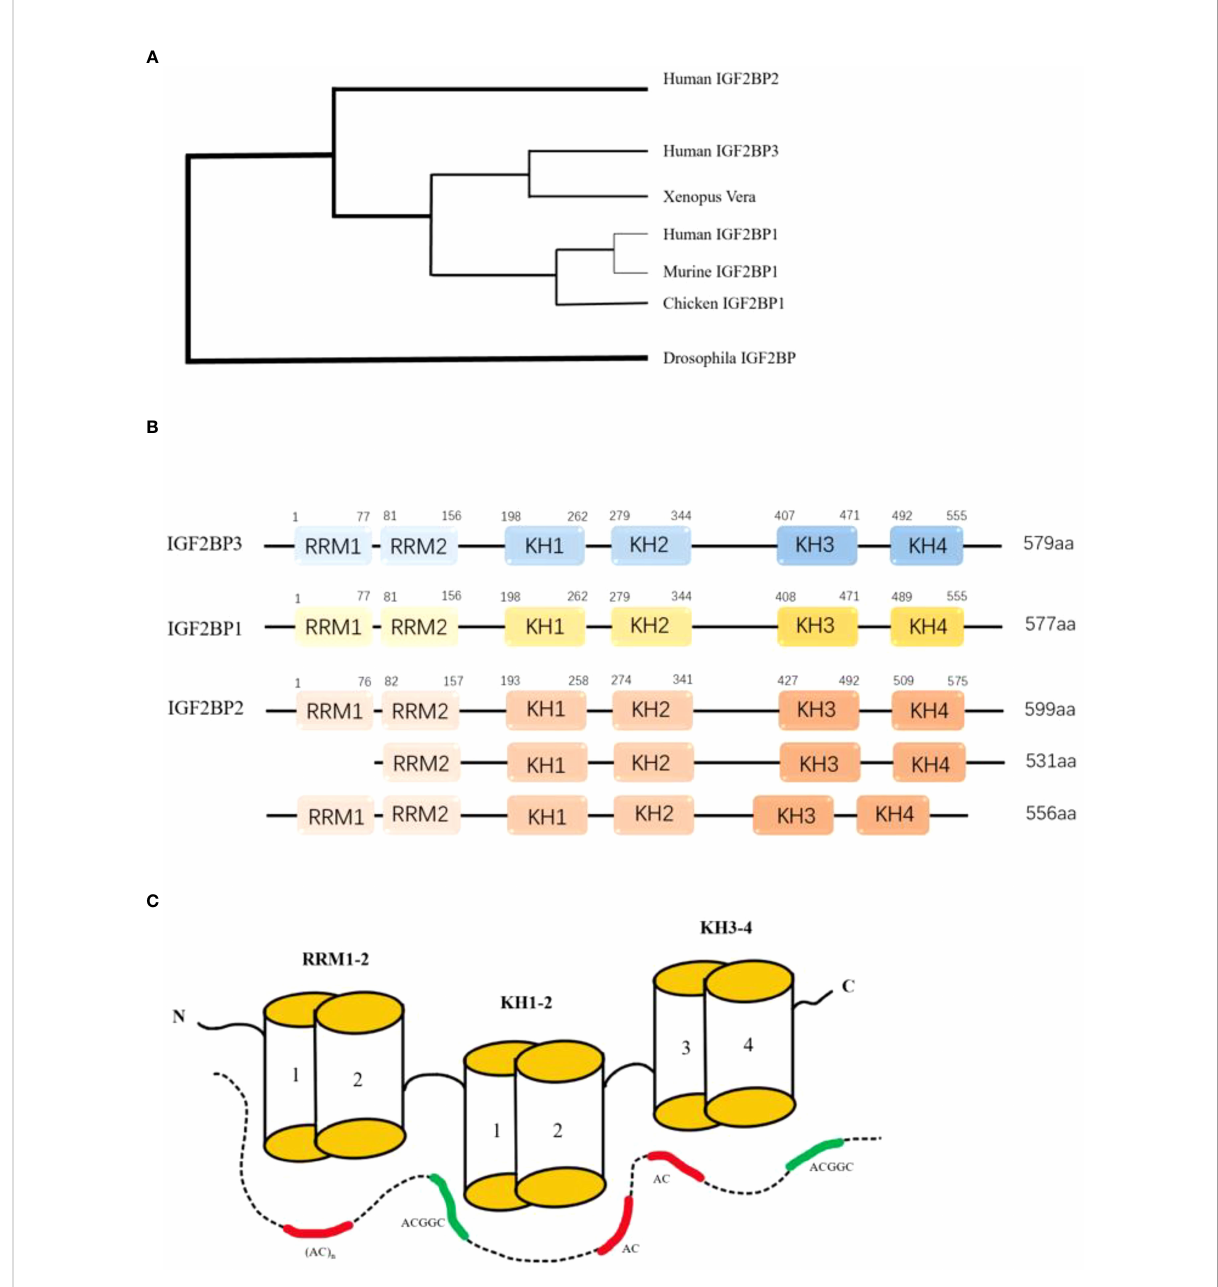
FIGURE 1 (A) The development tree of IMPs' homologous gene. (B) The six RNA binding domains of IGF2BPs: two RNA recognition regions at the N- terminal and four K homology regions at the C-terminal. All four KH domains contribute to RNA binding, ribonucleoprotein particle formation, and cell localization. (C) Model for RNA recognition by IGF2BPS. The combinations of the GGC-core elements with CA-rich motifs are shown for full-length IGF2BPs and the KH-containing derivatives. RCM: RNA recognition motif. KH:hnRNP-K homology